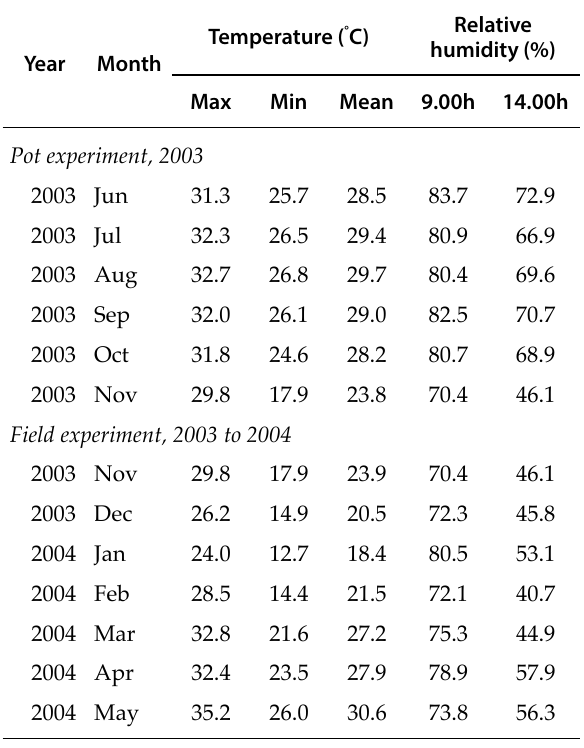
Table 1. Average temperatures and relative humidities recorded during the periods of the pot and field experi -